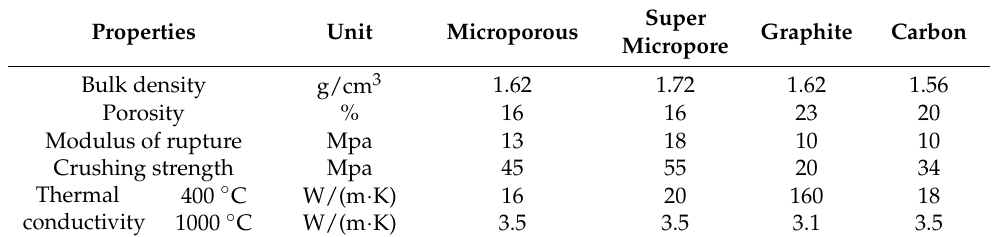
Table 1. Properties of different carbonaceous bricks in hearth lining, data were compiled from [8].